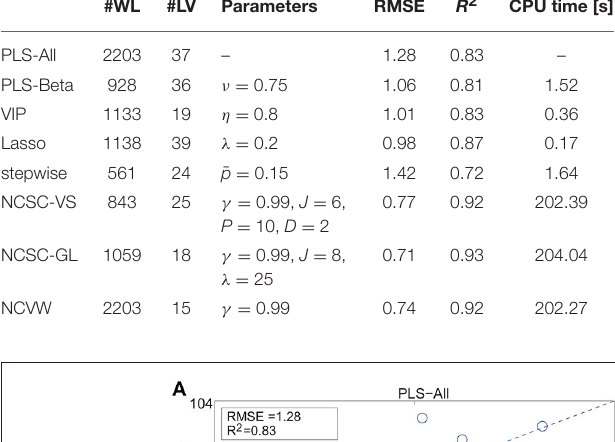
TABLE 2 | API content estimation results.